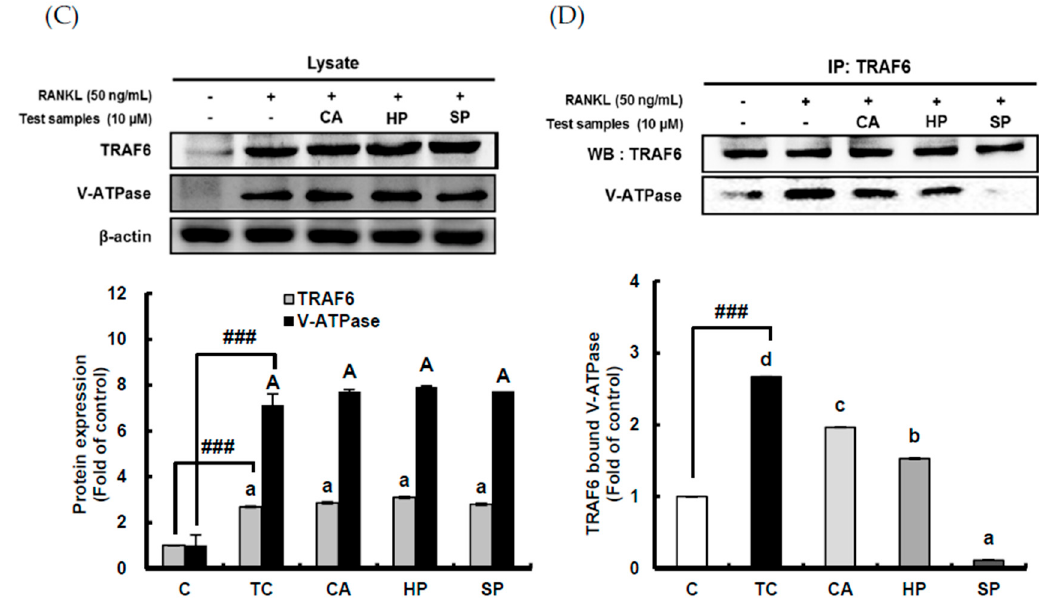
Figure 6. Suppressive effect of hydroethanolic extract of A. capillaris and three bioactive compounds on tumor necrosis factor receptor-associated factor 6 (TRAF6) and vacuolar H + -adenosine triphosphatase (V-ATPase) expression and their interaction. ( A ) The effect of A. capillaris hydroethanolic extract (ACHE) on TRAF6 and V-ATPase expression and ( B ) their interaction. ( C ) The effect of three bioactive compounds on TRAF6 and V-ATPase expression and ( D ) their interaction. RAW 264.7 cells were exposed to RANKL (50 ng/mL) for 5 days in the absence and presence of ACHE (20 µ g/mL) or three bioactive compounds (10 μ M). The cells were lysed and cell lysates were incubated with TRAF6 or V-ATPase antibody and protein A beads. After washing the beads, precipitated proteins and cell lysates were separated by sodium dodecyl sulfate-polyacrylamide gel electrophoresis (SDS-PAGE) and immunoblotted for the indicated proteins using specific antibodies. Data are expressed as percentages of the values of untreated cells (means ± standard deviations, n = 3). ## p < 0.01, ### p < 0.001 vs. C; *** p < 0.001 vs. TC. C: control, which was not treated; TC: treated control, which was treated with RANKL; CA: chlorogenic acid; HP: hyperoside; SP: scoparone; NS: